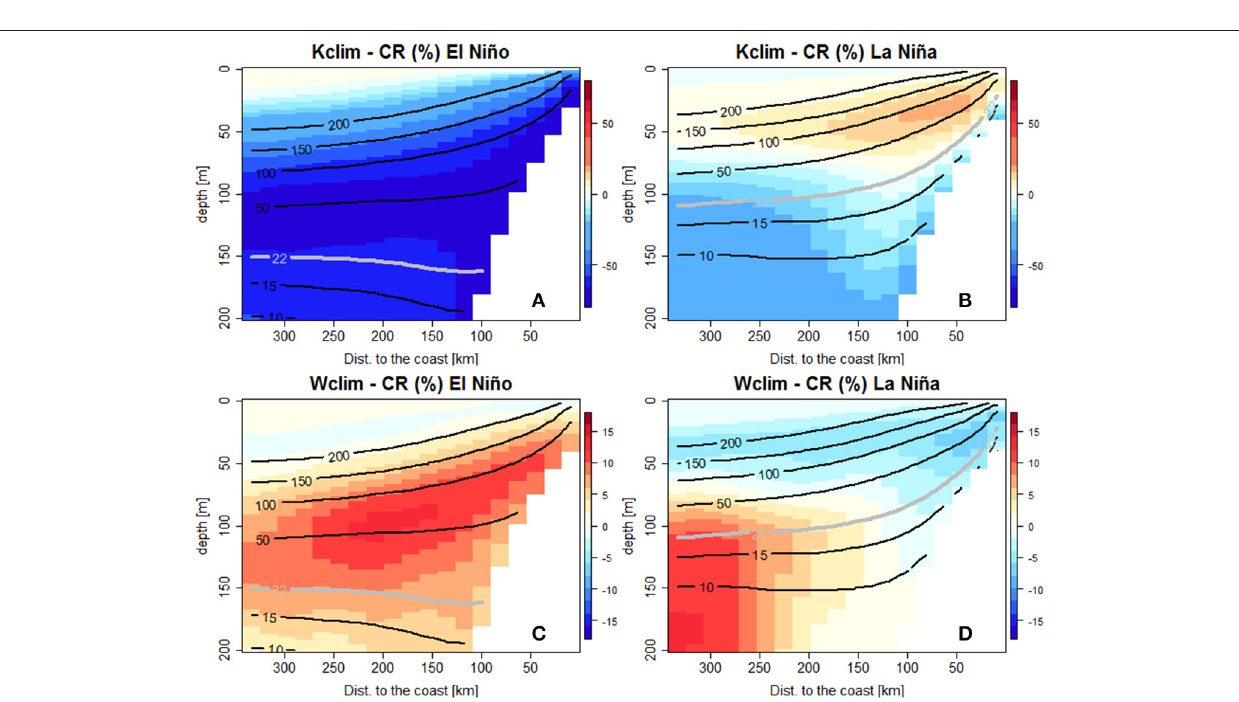
FIGURE 11 | Alongshore-averaged vertical sections of DO concentration change (in %) for Kclim (A,C) and Wclim (B,D) with respect to CR, during LN (top) and EN (bottom). Black isolines mark DO concentration during LN (A,B) and EN (C,D) in the CR simulation. Note the different scale for Kclim and Wclim due to the stronger DO changes in